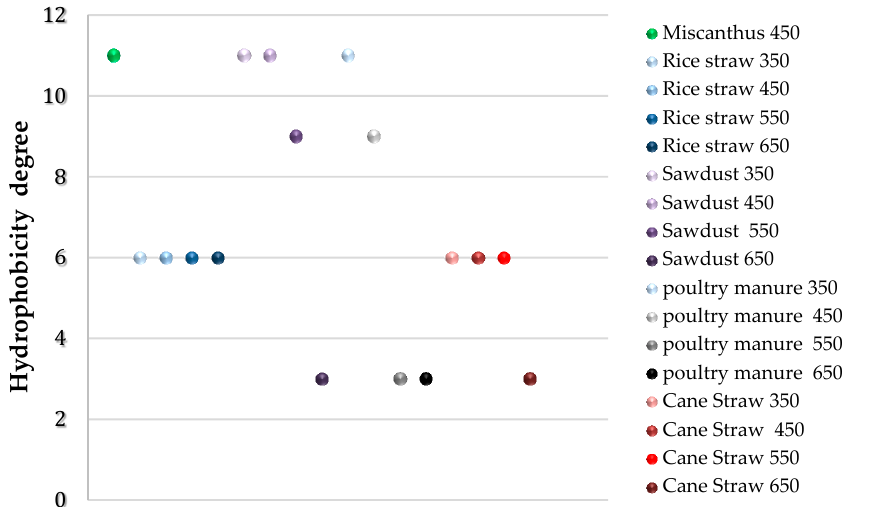
Figure 2. Hydrophobicity Miscanthus biochar pyrolyzed at 450 °C the scale 0–12 is indicative of degree of hydrophobicity ( ≤ 1 not water repellent; 2: Very low; 3–5: Low; 6–8: moderate, 9–10: Severe; 11–12: very severe).